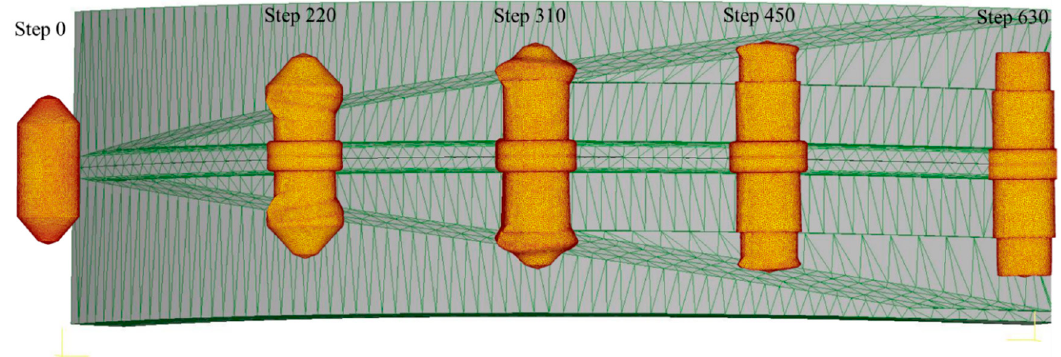
Figure 9. Finite element simulation of a variable cone angle billet forming to be stepped shaft by cross-wedge rolling.